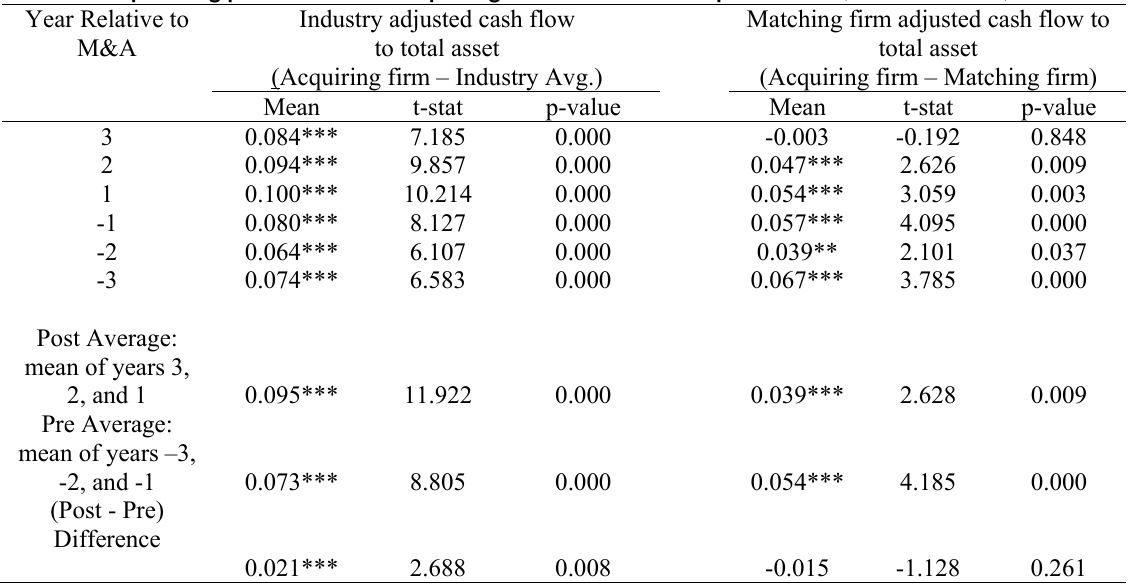
Table 6. Operating Performance (Cash Flow to Total Assets) for Pre- and Post- Merger